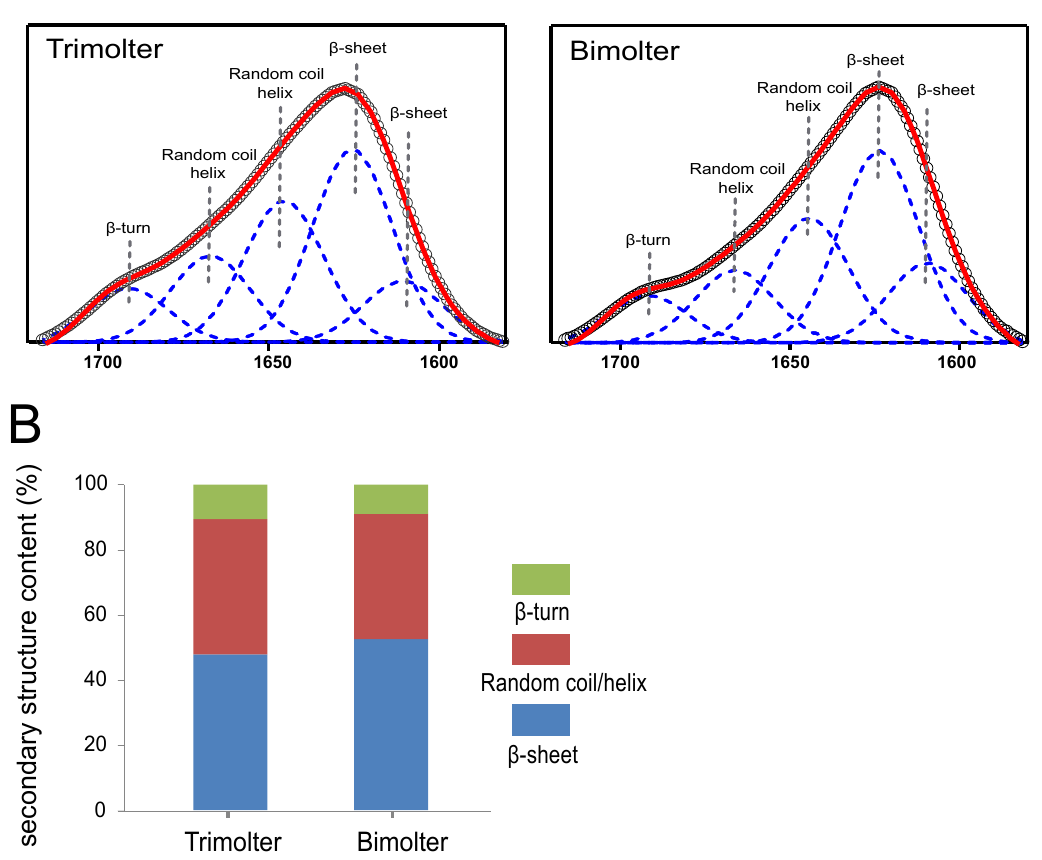
Figure 6. Attenuated total internal reflection Fourier transform infrared spectroscopy (ATR-FTIR) spectra of silk fibers. ( A ) Deconvolution results of the amide I band of trimolter and bimolter silk fibers. ( B ) Comparison of the secondary structures of the silk fibers from di ff erent group; circles, original spectrum; dashed curve, deconvoluted peaks; red curve, simulated spectrum from summed